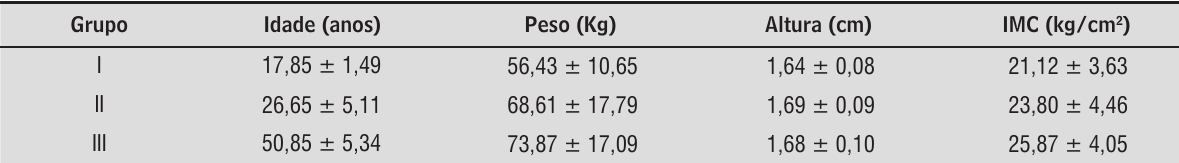
Legenda: Kg = kilograma; cm = centímetro; IMC = índice de massa corporal Fonte: Dados da